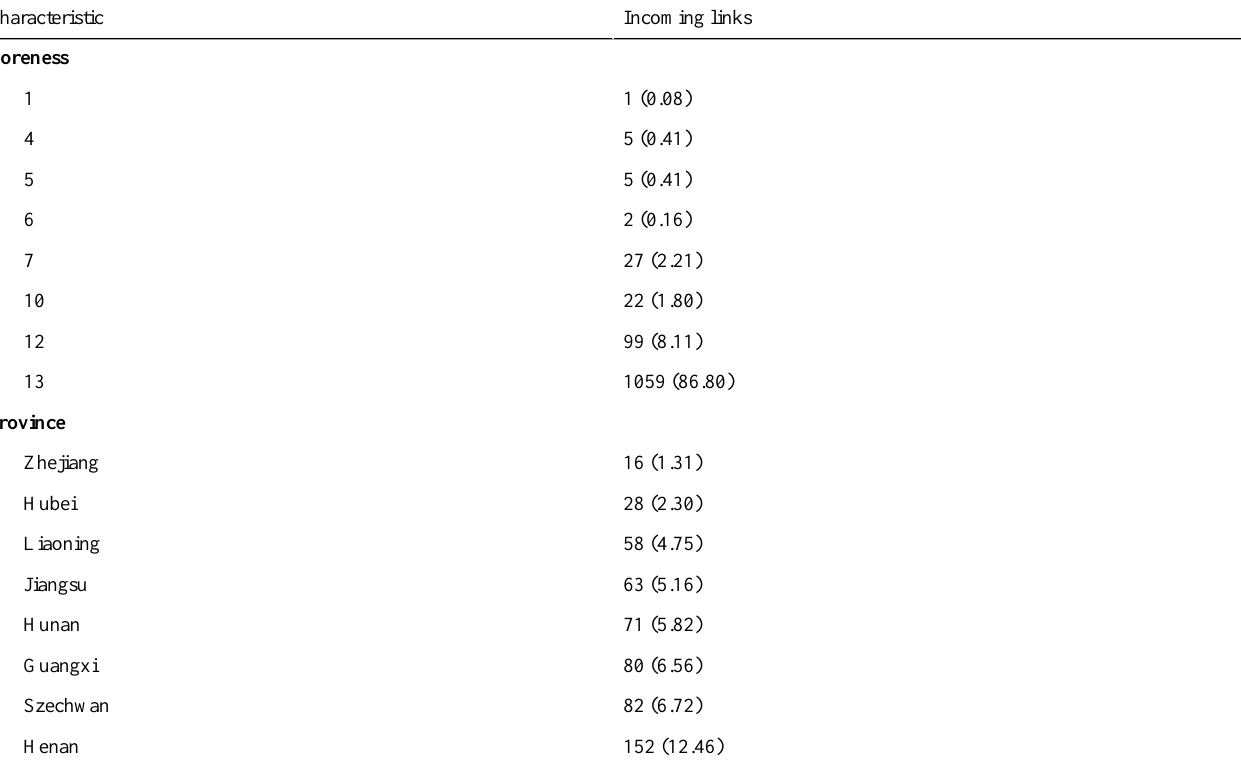
Table 2. Comparison of the in-strengths of each shell (coreness) and the innermost nodes (provinces) based on the COVID-19 epidemic network in the study period (N=1220 links), n